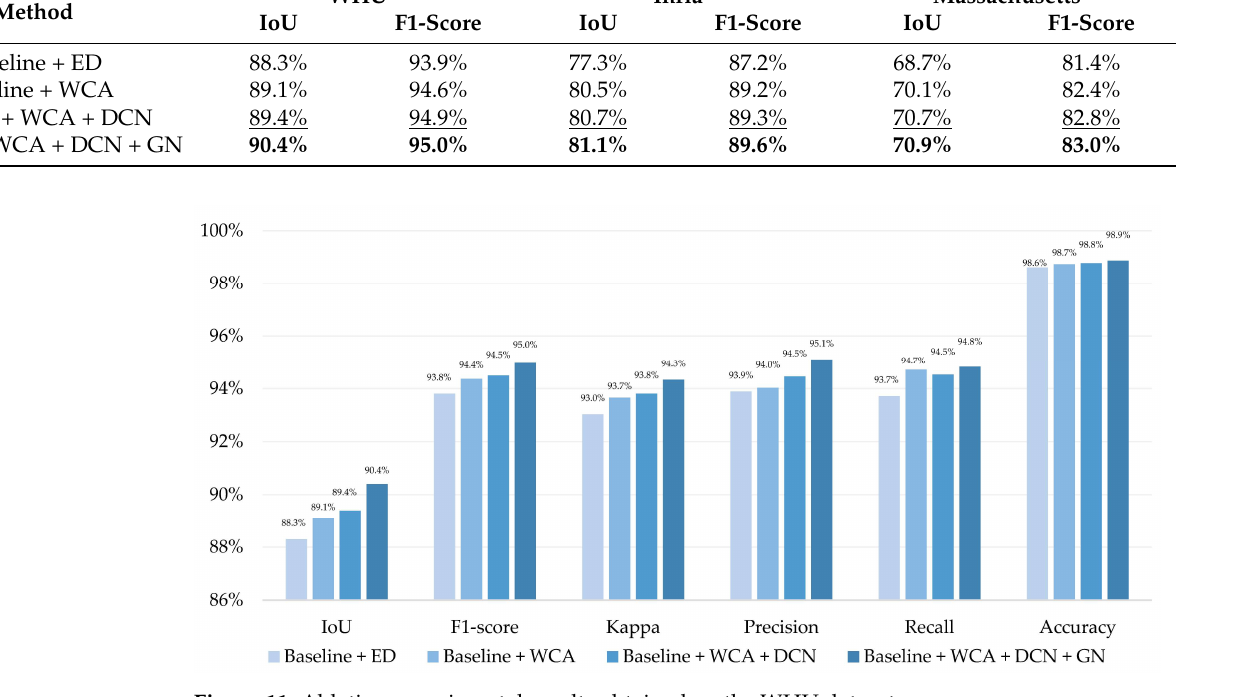
Figure 13. Ablation experimental results obtained on the Massachusetts dataset. 4.5. Limitations and Future Work Despite superior performance achieved by the proposed MSL-Net in accuracy and complexity, MSL-Net still has limitations that need to be addressed. The experimental re- sults of MSL-Net on the Inria dataset with more complex scenes have insignificant ad- vantages over those of PSPNet, and it is still necessary to strengthen the robustness of lightweight MSL-Net in complex scenes. Additionally, the number of parameters of the ASPP module accounts for a large proportion of that of the whole network. In future work,